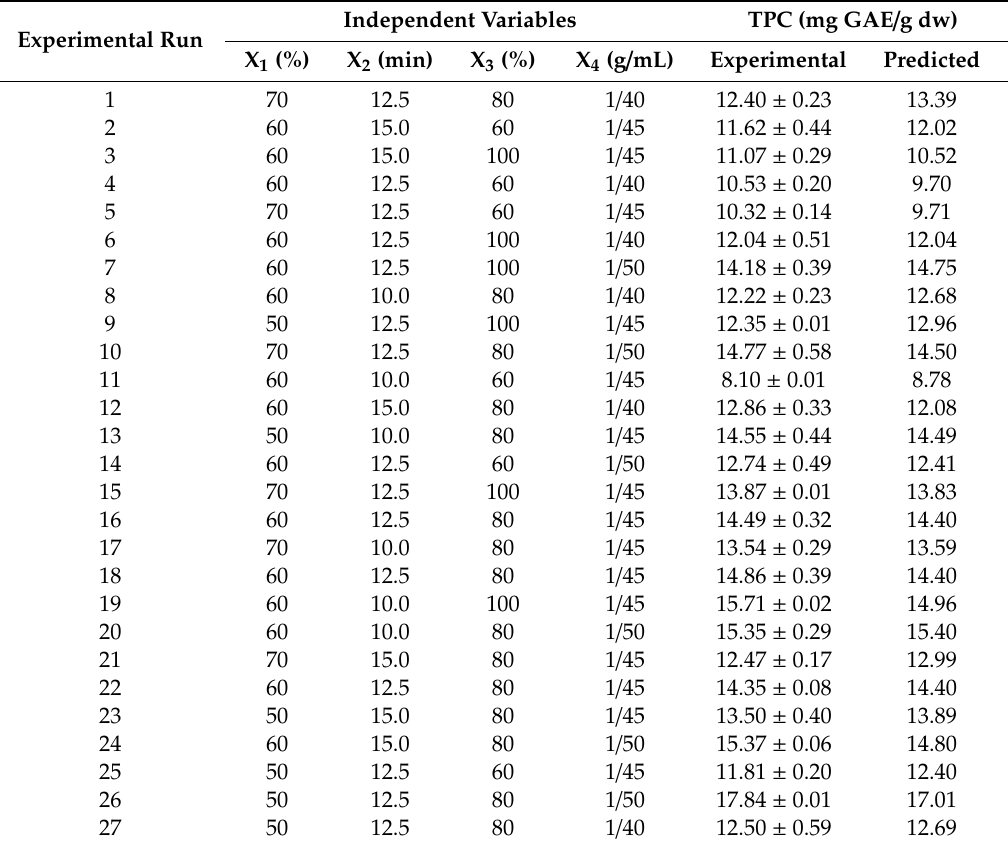
Table 1. Experimental and predicted values of Total Phenolic Content (TPC) obtained by ultrasound-assisted extraction (UAE) with di ff erent conditions used in the randomized Box–Behnken